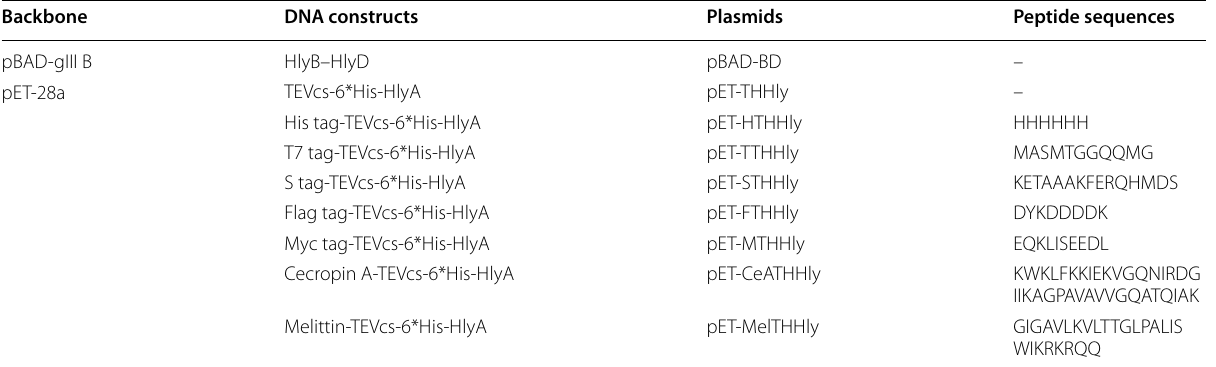
Table 3 Summary of the plasmids, DNA constructs, and peptide sequences